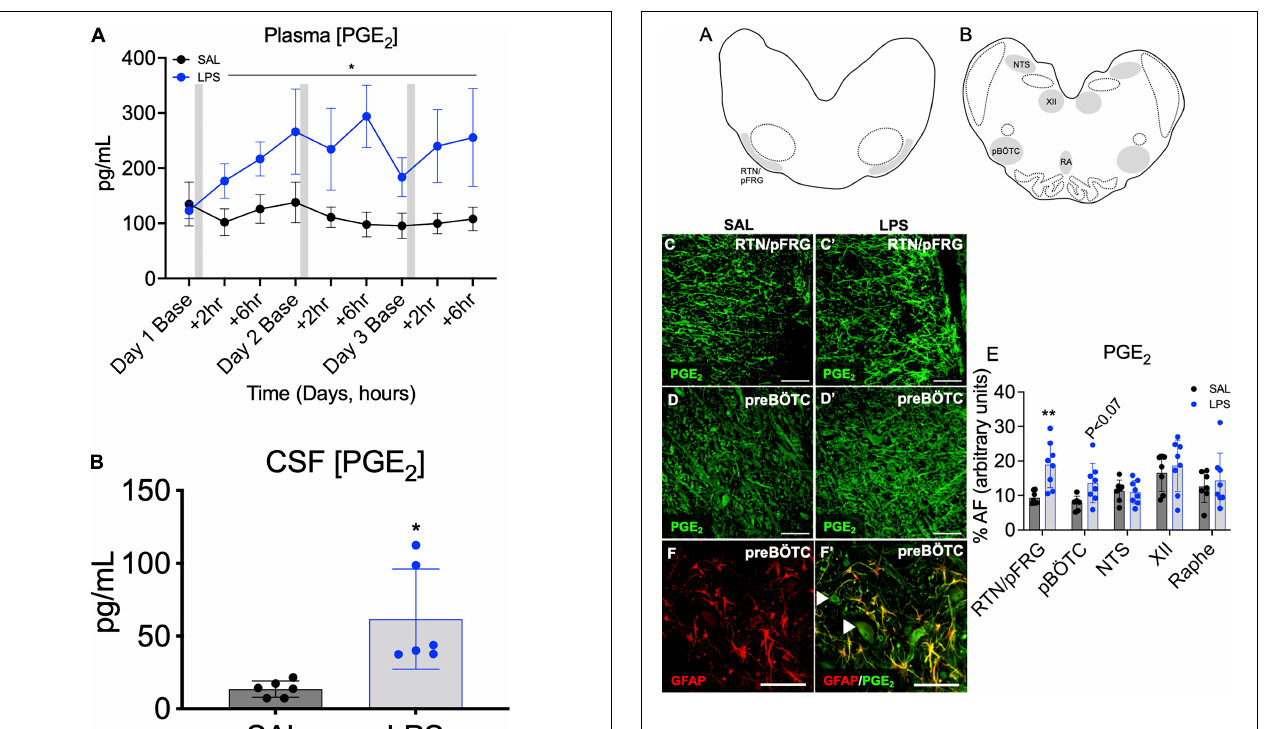
FIGURE 4 | PGE 2 expression in brainstem respiratory centers. Schematic diagram of brainstem respiratory centers analyzed: RTN/pFRG (A) , preBÖTC, NTS, XII, and raphe nucleus (B) . Representative photomicrographs of PGE 2 (green) staining in the RTN/pFRG in SAL (C,C’) and LPS exposed fetuses (D,D’) . Area fraction of PGE 2 staining in brainstem respiratory centers in SAL (control = black, n = 8) and LPS-exposed fetuses (blue, E , n = 8). Data are means ± SD, ** P < 0.01 vs. control. Representative photomicrographs of GFAP (red) merged with PGE 2 (green) showing co-localization of PGE 2 to GFAP + astrocytes within the preBÖTC. White arrowheads indicate PGE 2 positive neurons (F,F’) . Scale = 20 µ